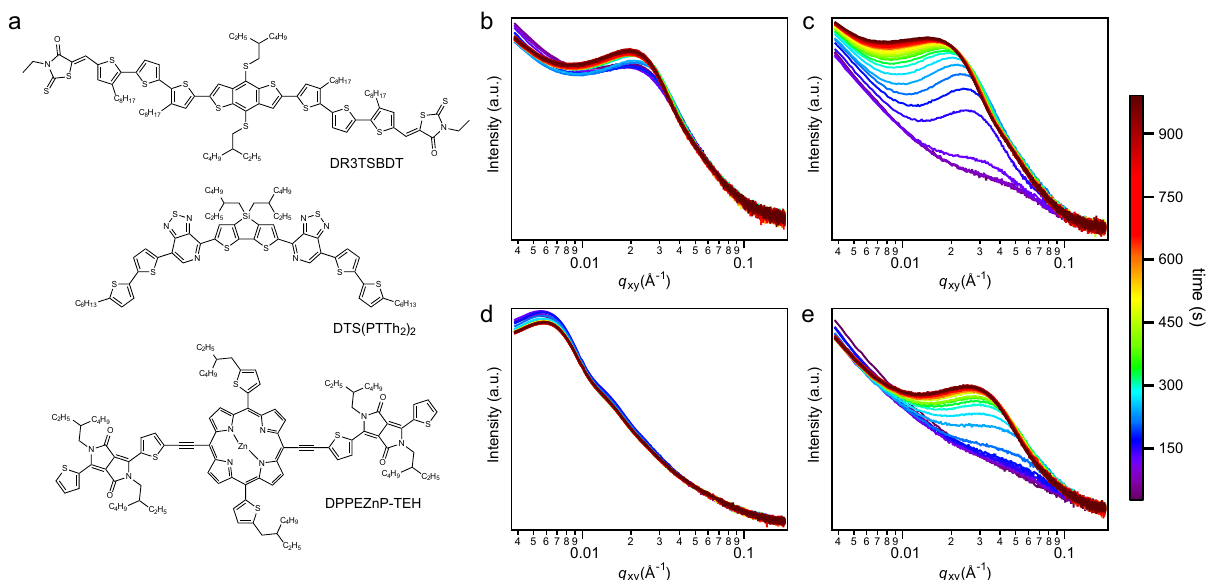
Fig. 1 Chemical structure and in situ grazing-incidence small-angle X-ray scattering (GISAXS). a Chemical structure of DR3TSBDT, DTS(PTTh 2 ) 2 and DPPEZnP-TEH. b – e In situ GISAXS in-plane pro fi les of b DR3TSBDT:PC 71 BM, c DTS(PTTh 2 ) 2 :PC 71 BM, d DPPEZnP-TEH:PC 61 BM and e DPPEZnP-TEH: PC 61 BM/Py (scattering data was collected every 30 s with 2 s exposure